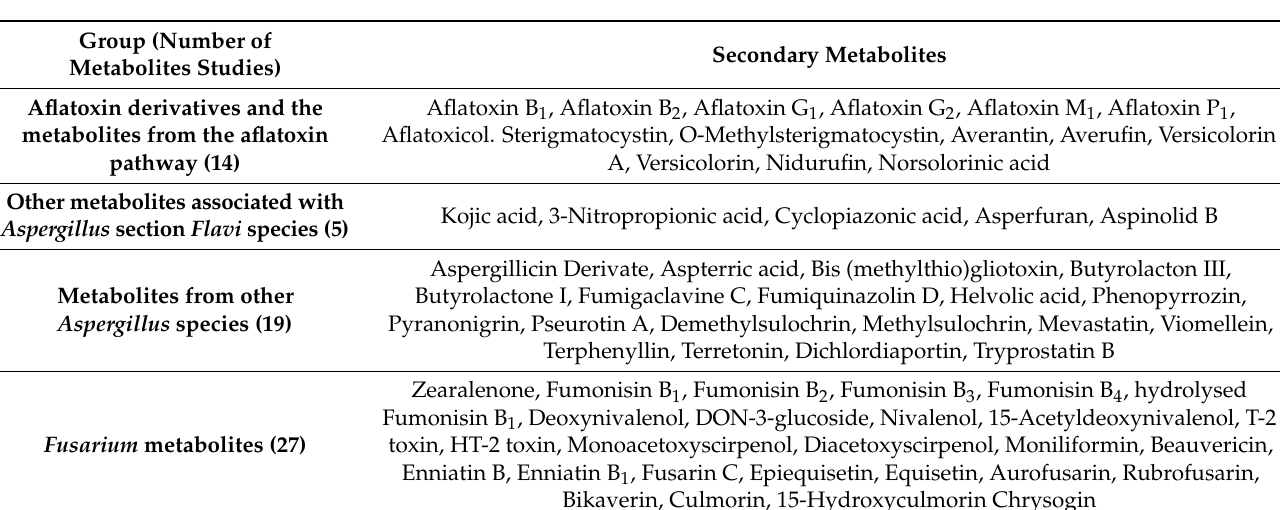
Table 1. List of the different secondary metabolites examined in this study where standards were